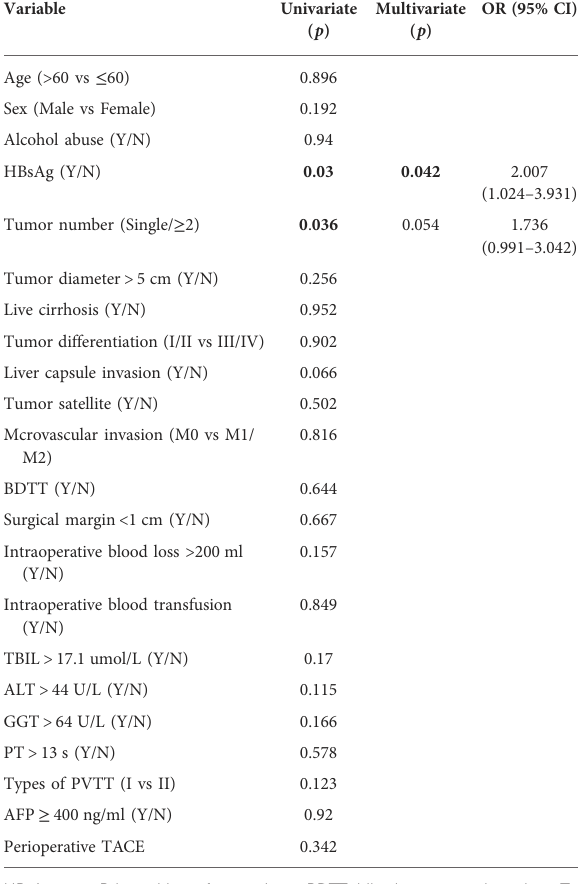
TABLE 4 Univariate and multivariate analysis of prognostic factors that related with survival.